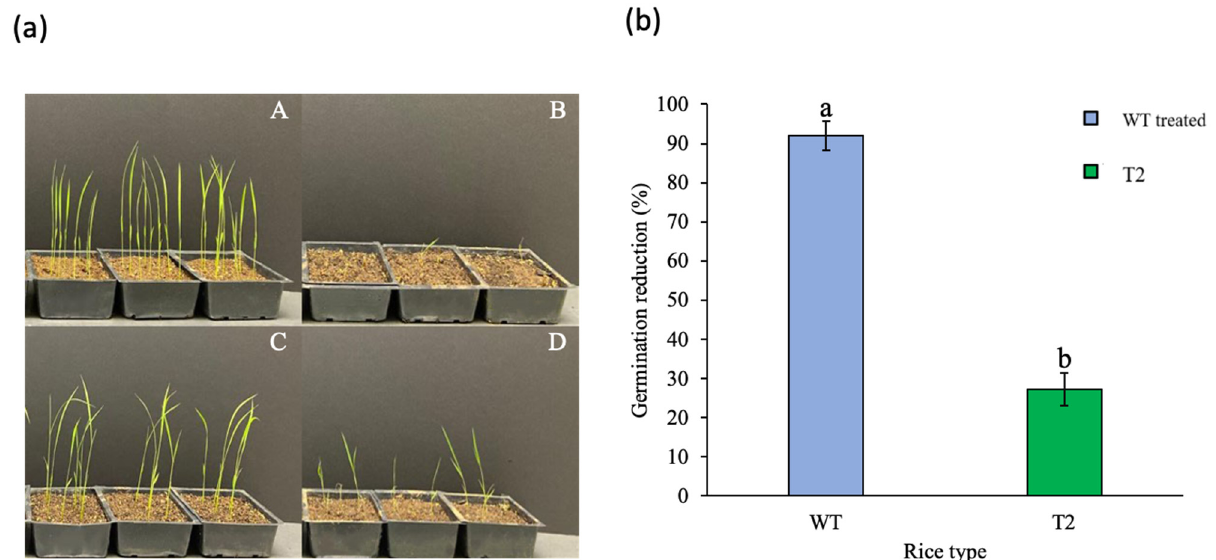
Figure 2. Response of transgenic rice plants to soil-applied fomesafen (390 g ha − 1 ). ( a ) The response of wild type and T 2 rice plants 3 weeks after soil treatment. The photos show one run of the experiment; ( A ) WT nontreated, ( B ) WT treated, ( C ) T 2 nontreated, and ( D ) T2 treated. ( b ) Wild-type and T 2 germination reduction (%) calculated 3 weeks after soil-applied fomesafen treatment. Means were derived from a combined analysis of two runs since plant response to treatments did not vary across runs. Lowercase letters indicates significant difference ( p < 0.05).